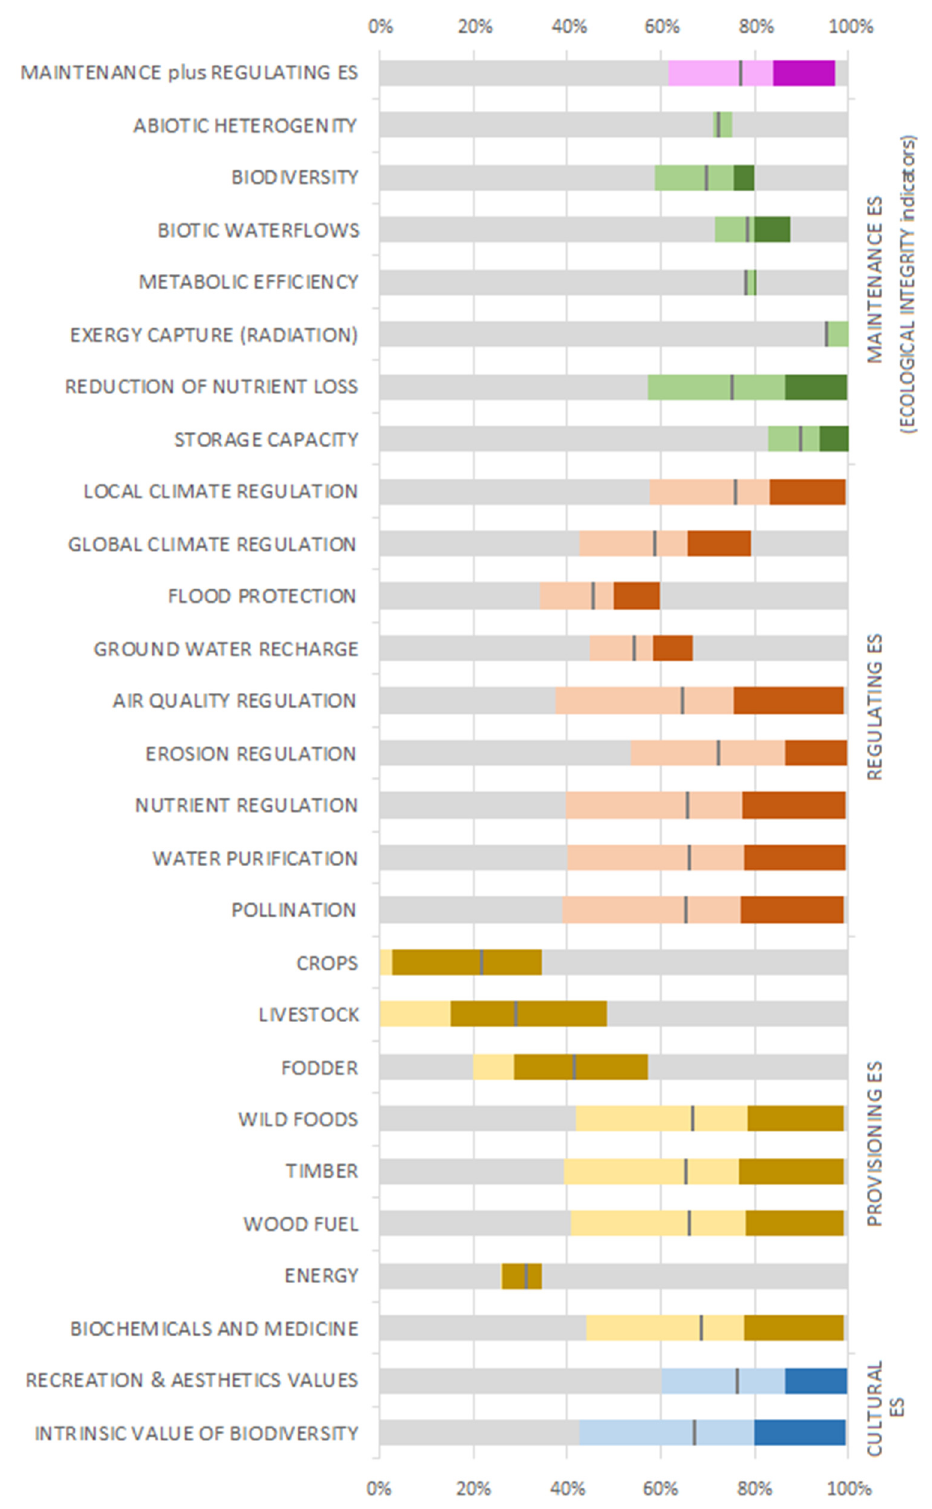
Figure 7. Distributions of capacity to supply ES in 10% of least resistant cells under the GI corridors in the research area. Bars divided to quartiles indicate the distribution of supplies of respective ES in cells, where the minimum value is 0% and maximum is 100%. The thin grey line indicates the mean value. The relative scale allows comparison of distribution of values of each ES with summarized supplies for indicators of maintenance and regulating ES.